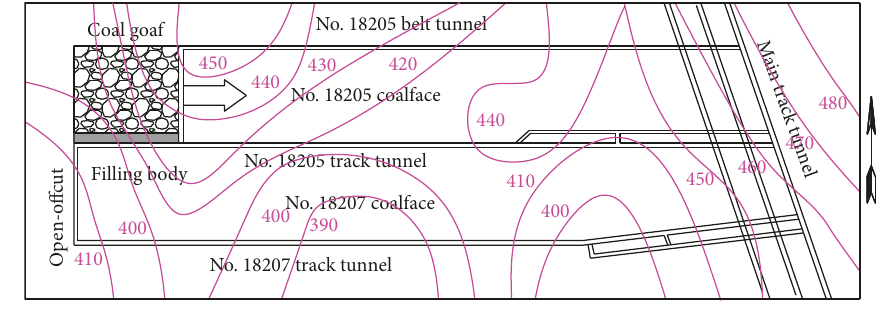
Figure 3: Layout diagram of the No. 18205 coalfaces and tunnels.